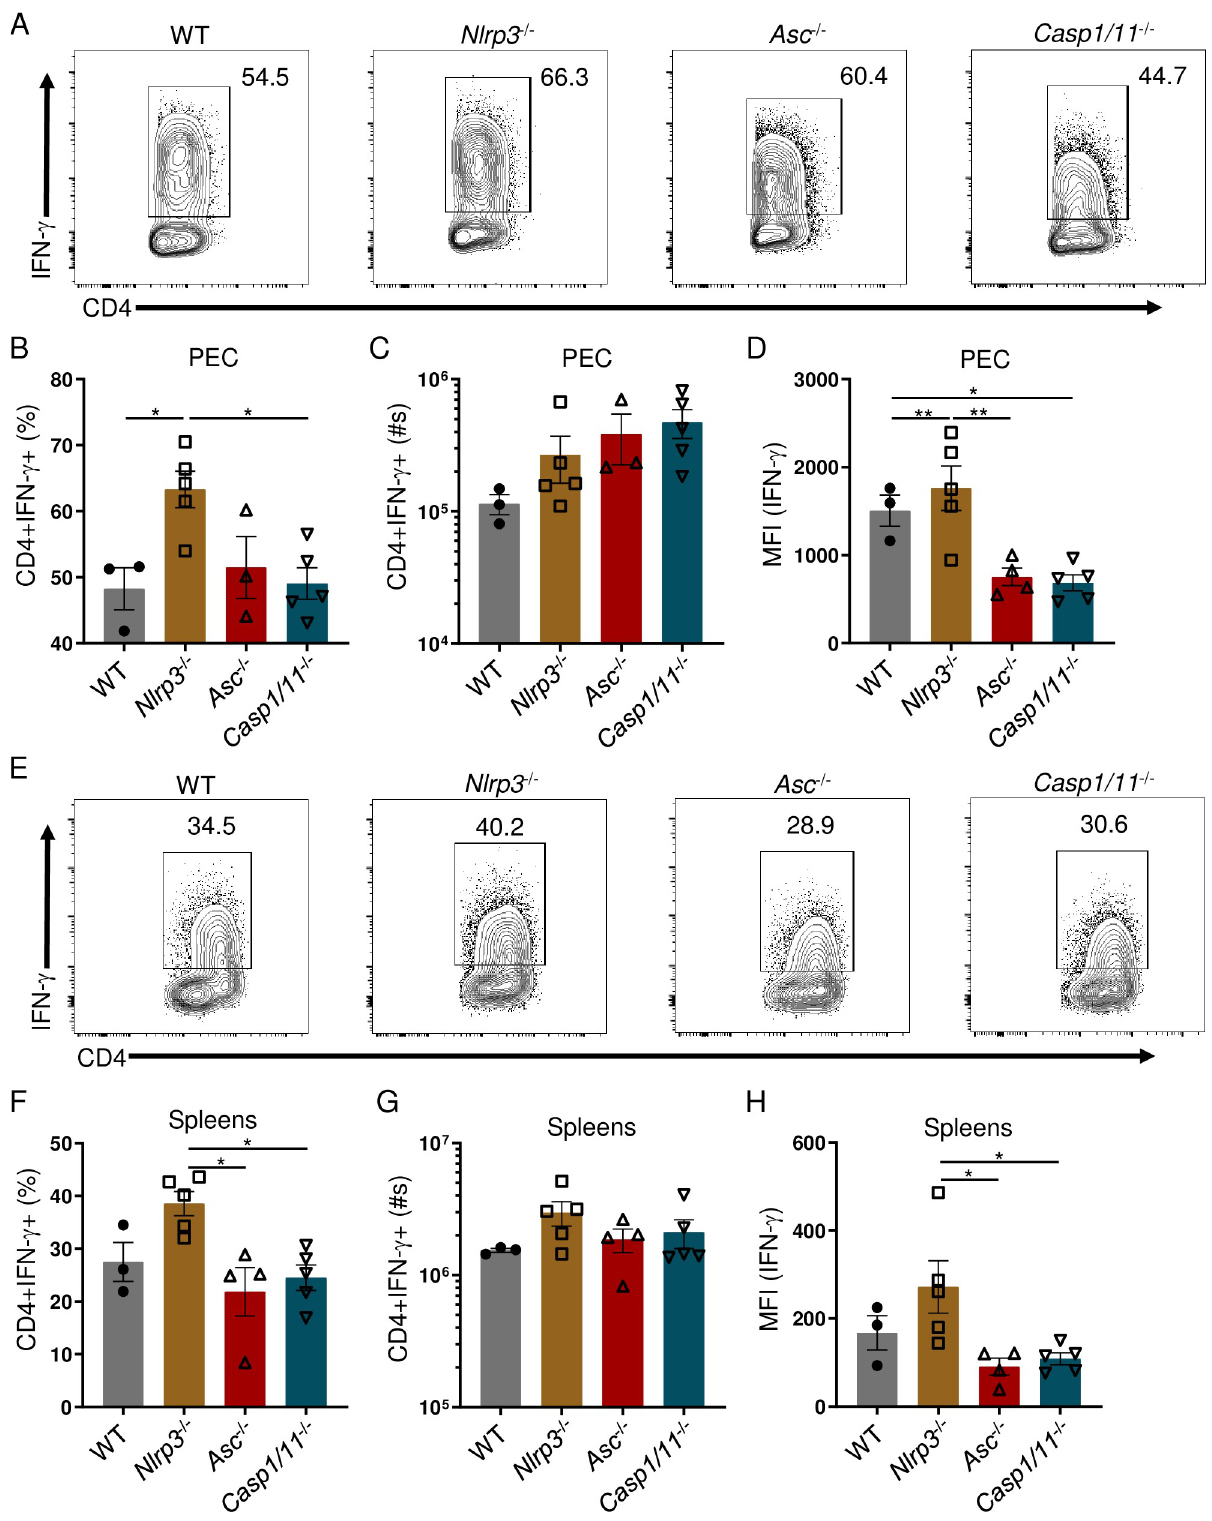
Fig 2. The inflammasome has a limited role in stimulating T. gondii- mediated CD4+ T Casp1/11 -/- mice were i.p. infected with 20 cysts of T . gondii . PECs (A) and spleens (E) were harvested and IFN- γ production by CD4+ T cells was analyzed by flow cytometry. ( B, C, F, G ) Average frequencies (B, F) and absolute quantification (C, G) of CD4+IFN- γ + cells in the PECs and spleens